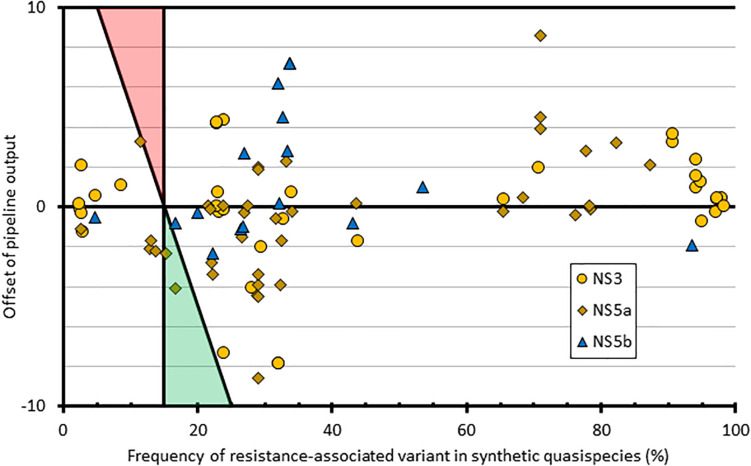
Graphical representation of how the pipeline outputs compare to quasispecies input at resistant loci with mixed amino acid frequencies. The x-axis comprises the frequency of each variant within the input quasispecies; the y-axis shows the difference between the input value and the pipeline output frequency at that variant. Shaded triangle regions represent the area where false positives (red) and false negatives (green) would be observed, using the pipeline variant calling threshold of 15%.